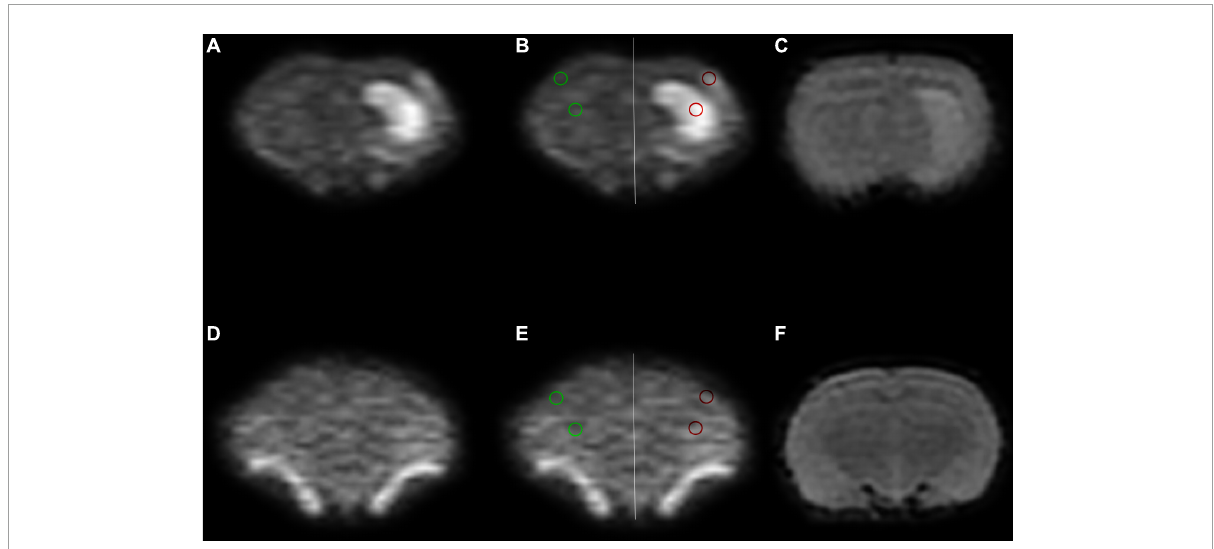
FIGURE1 Region of interest (ROI) placement diagram. (A–C) The ischemia group. (D–F) The sham group. The selected ROIs are shown on the DWI 4000 maps. ROI1 (red circle) was bounded by the lesions on DWI4000, and ROI2 (green circle) was bounded by cortical regions, and the same sized ROIs were drawn in the symmetrical region of the bilateral lobes, avoiding the interference areas, such as the cerebrospinal fluid and blood vessels.